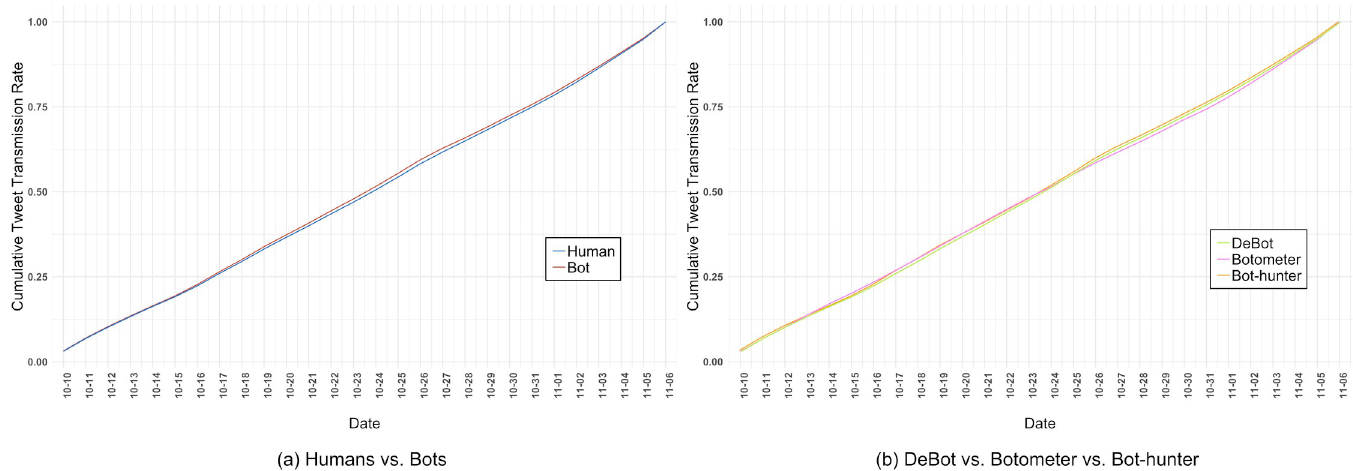
Fig 3. Cumulative tweet contribution rates for the 2018 U.S. midterm OSN conversation (October 10 –November 6, 2018) from the (a) human (blue) / bot (red) and (b) DeBot (green) / Botometer (pink) / Bot-hunter (orange) account classification perspectives.